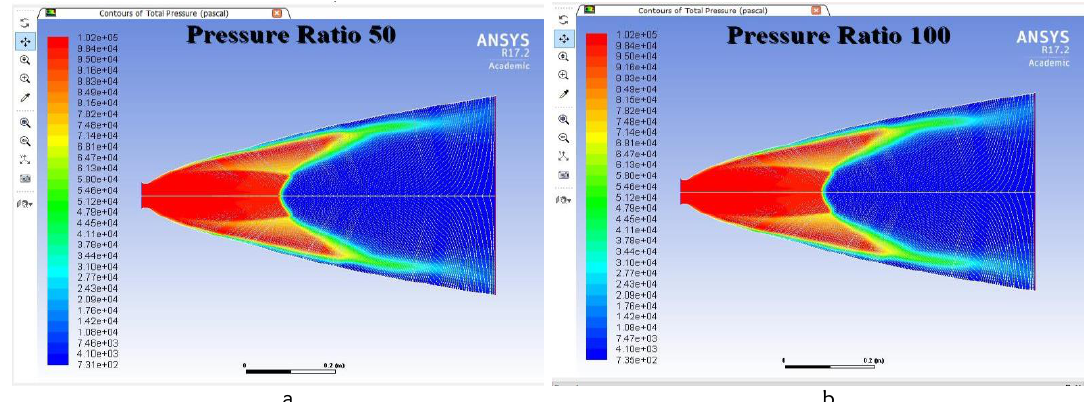
Figure 5: Contour of total pressure for pressure ratio 50 (a) and 100 (b)